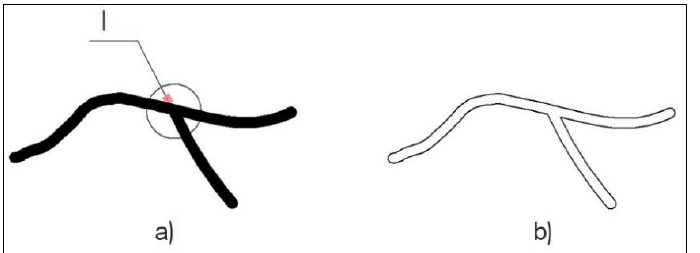
Figure 5. Conversion of a tree-like curve into a closed contour: a) – initial curve; b) – obtained closed contour as a result of the transformation